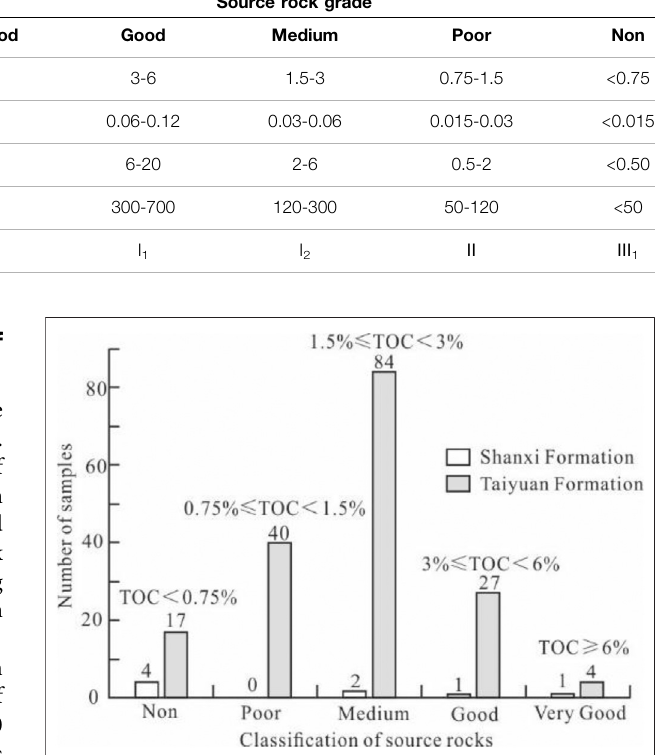
FIGURE 4 | TOC evaluation statistics for typical